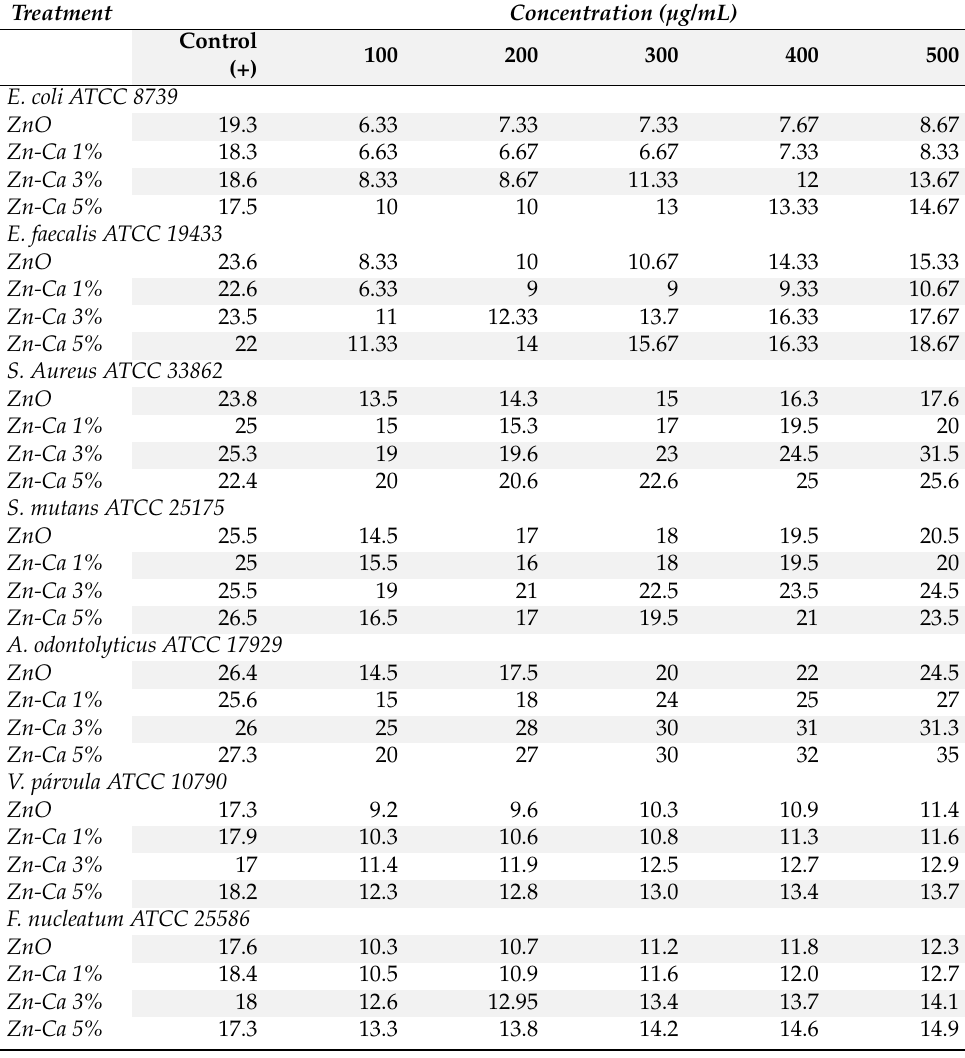
Table 2. Antimicrobial activity of ZnO-CaO